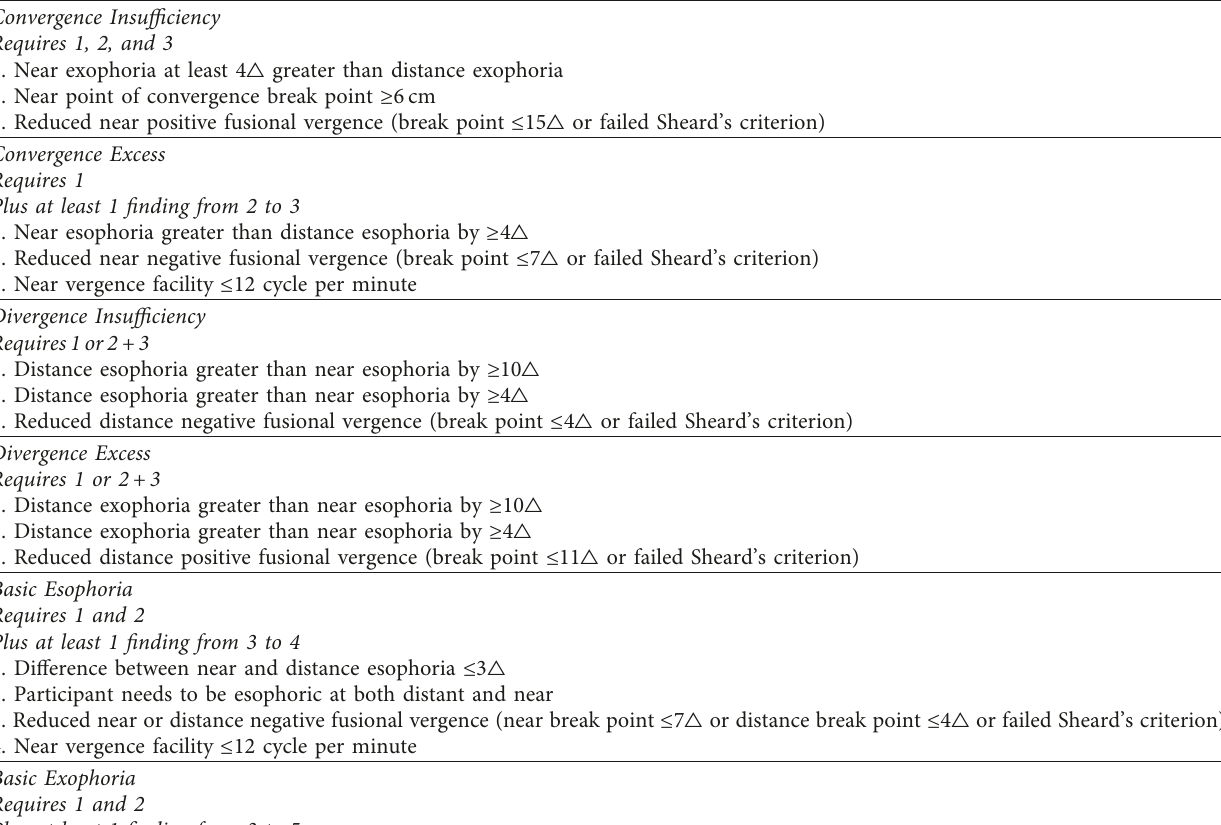
Table 1: Diagnostic criteria for vergence and accommodative